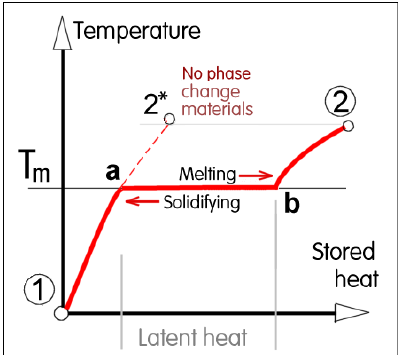
Fig. 3. Dependence between variations of temperature and internal thermal energy of a substance with and without phase change between the input state 1 and final states 2 or 2*.